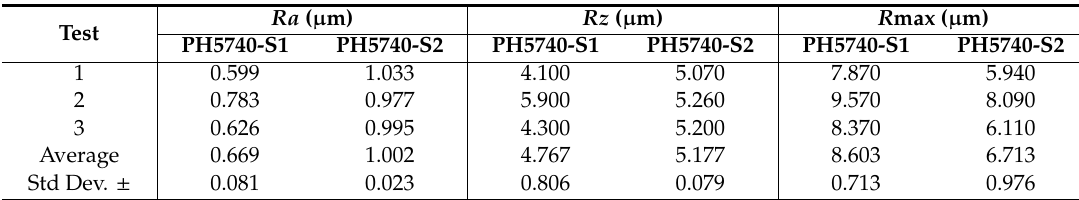
Table 9. Surface roughness for PH5740 CVD TiN / TiCN / Al 2 O 3 coated inserts with a cutting length of 3,94 m